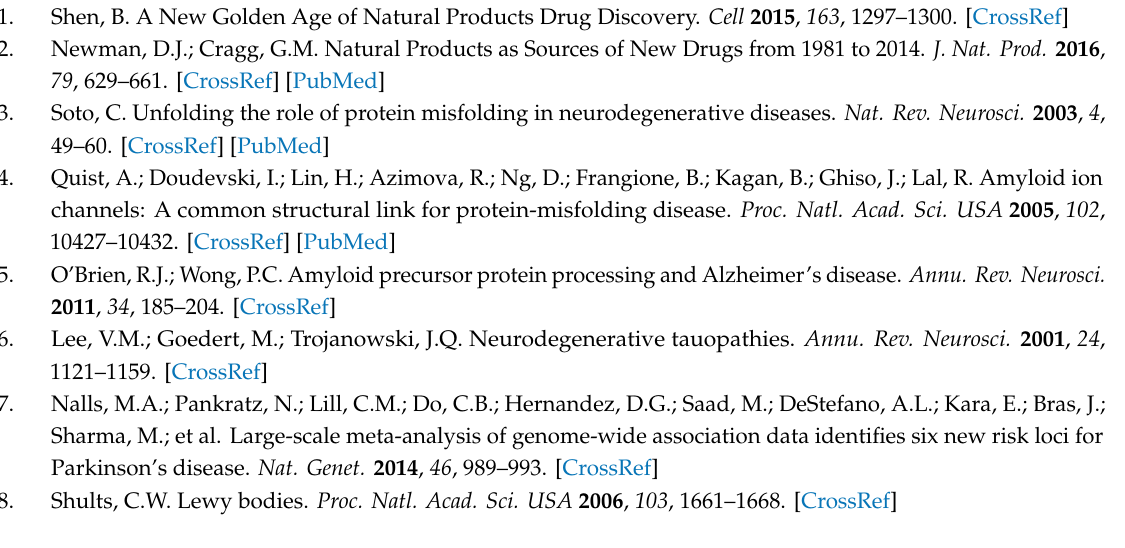
Table S1: Rubus species / varieties used in this study, Table S2: Significant compounds from runs test for all disease models tested, Table S3: Yeast strains used in this study, Table S4: Plasmids used in this study, Figure S1: PCA analysis of the entire positive mode dataset, Figure S2: PCA analysis of the entire negative mode dataset, Figure S3: Yeast model of Parkinson’s disease, Figure S4: Yeast model of amyotrophic lateral sclerosis, Figure S5: Yeast model of Huntington’s disease, Figure S6: Yeast model of Alzheimer’s disease, Figure S7: Yeast model of RAS / RAF interaction, Figure S8: Yeast model of Crz1 activation, Figure S9: Supplementary data for the cancer (HRAS / KRAS) model, Figure S10: Supplementary data for the Crz1 activation model, Figure S11: Visual representation of the runs